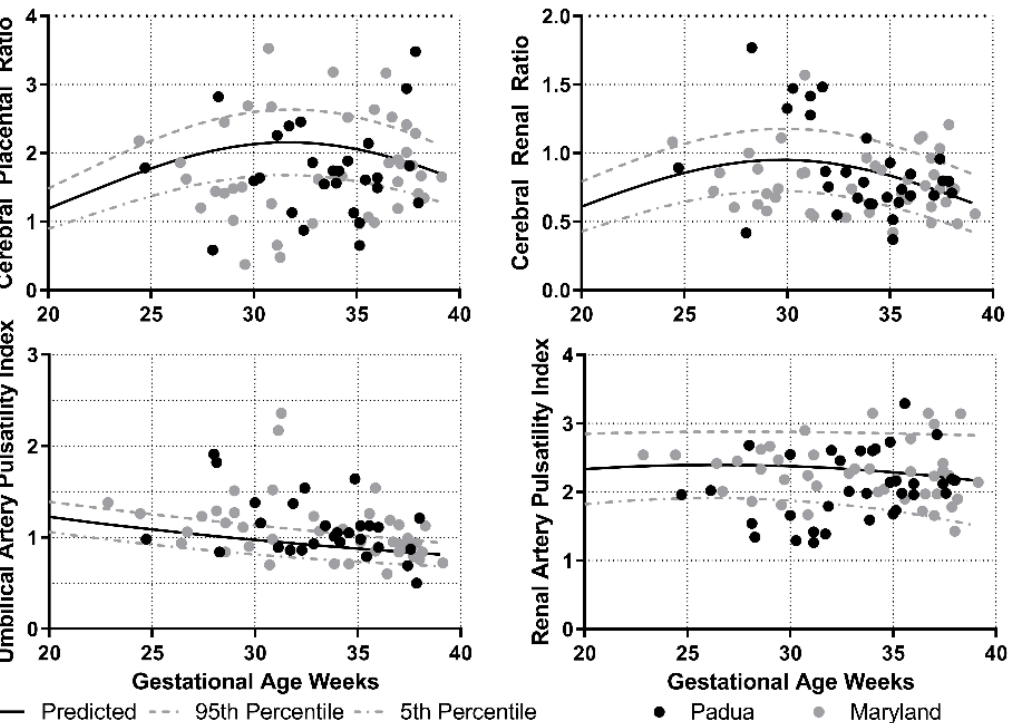
Figure 1. Doppler parameters and distribution by medical center.